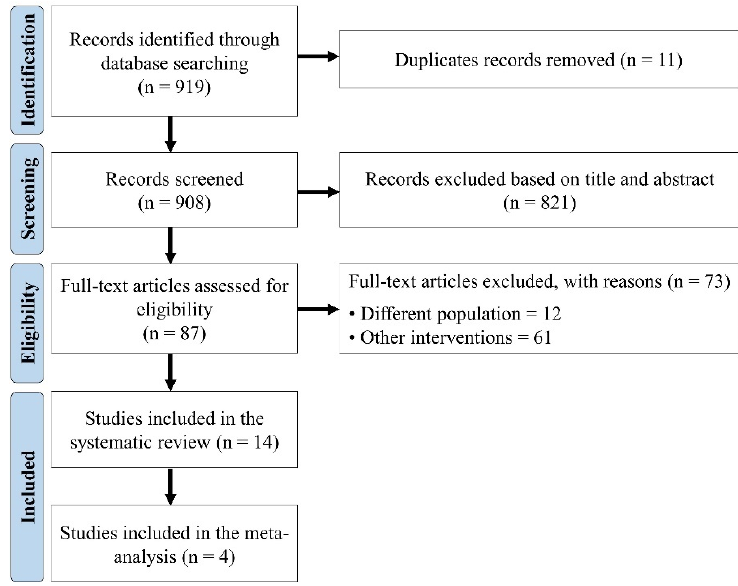
Figure 1. PRISMA flow diagram of study selection.